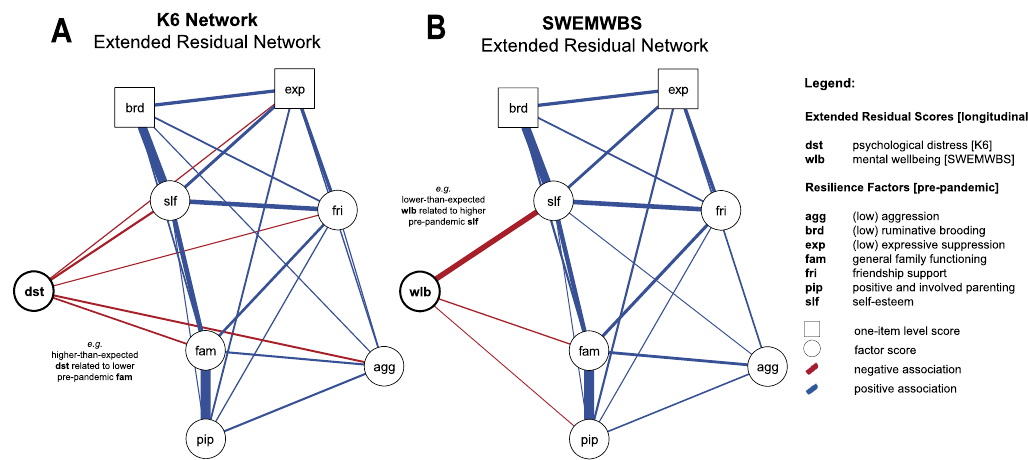
Figure 6. Resilience networks including extended residuals for both primary outcome measures, the Kessler Psychological Distress Scale ( A ; n = 632) and the Short Warwick-Edinburgh Mental Wellbeing Scale ( B ; n = 620). Extended residuals take into account individual pre-pandemic trajectories, reflecting the deviation from expected mental health whereas greater extended residuals of psychological distress (dst) relate to higher- than-expected distress, and lower extended residuals of mental wellbeing (wlb) relate to lower-than-expected wellbeing . Please note that the network layout has been averaged to ease